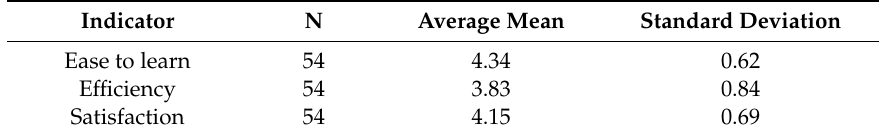
Table 18. Average scores of the evaluation of the system usability from indicator viewpoints.